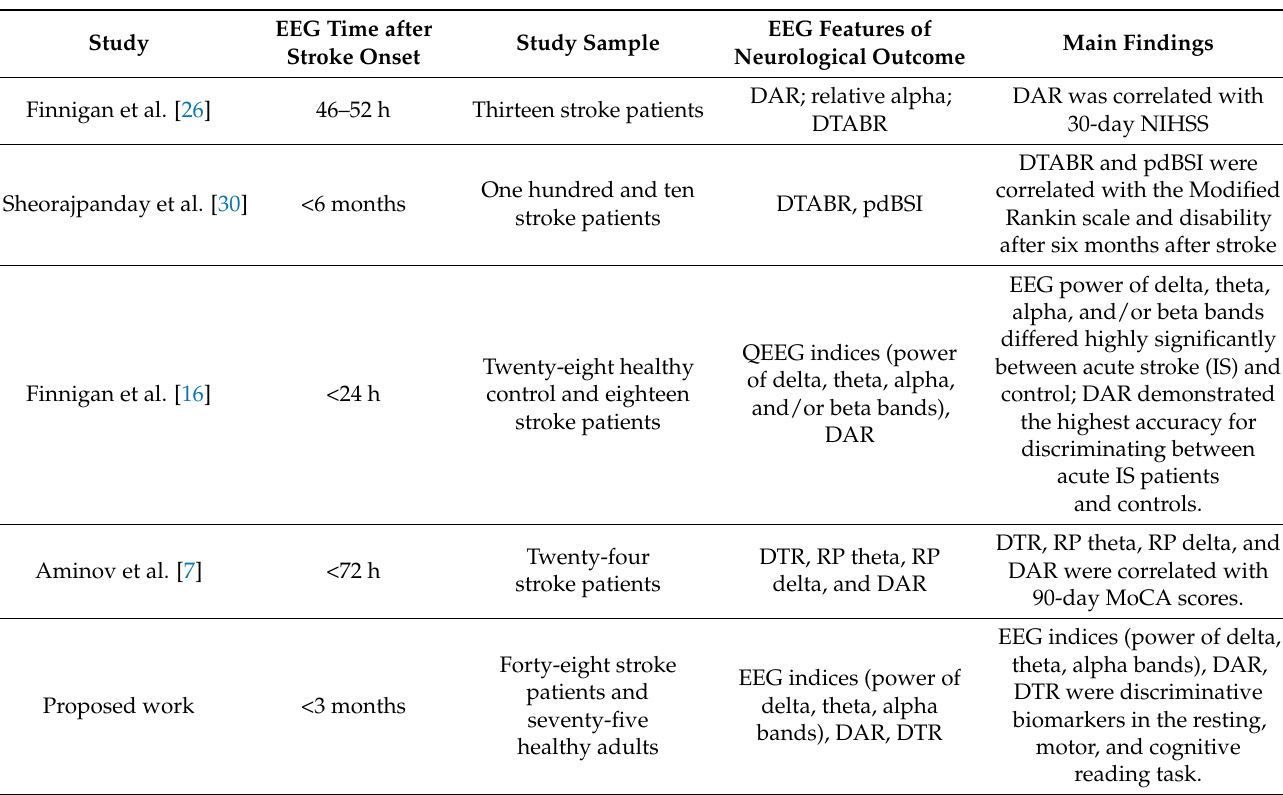
Table 6. Comparative study of methodologies and results between proposed work and previous